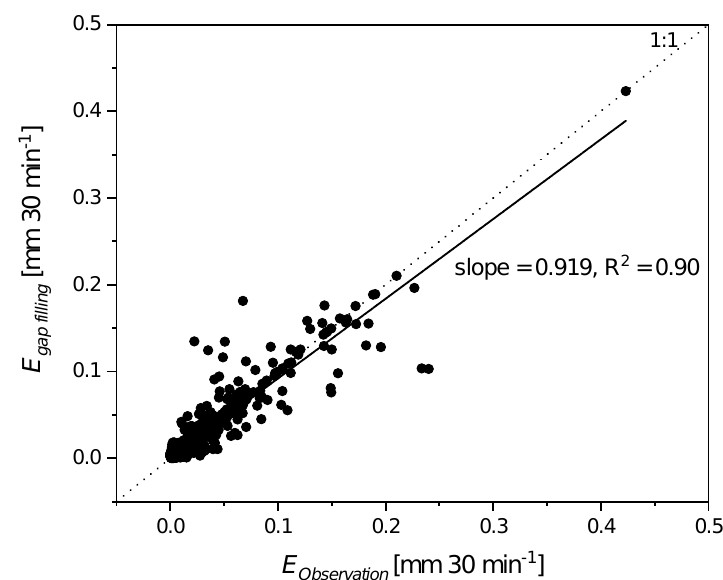
Figure 12. Comparison between marginal distribution sampling to fill artificial gaps of E under similar meteorological conditions during wetting–drying events, and the actual observation from eddy-covariance system ( n =